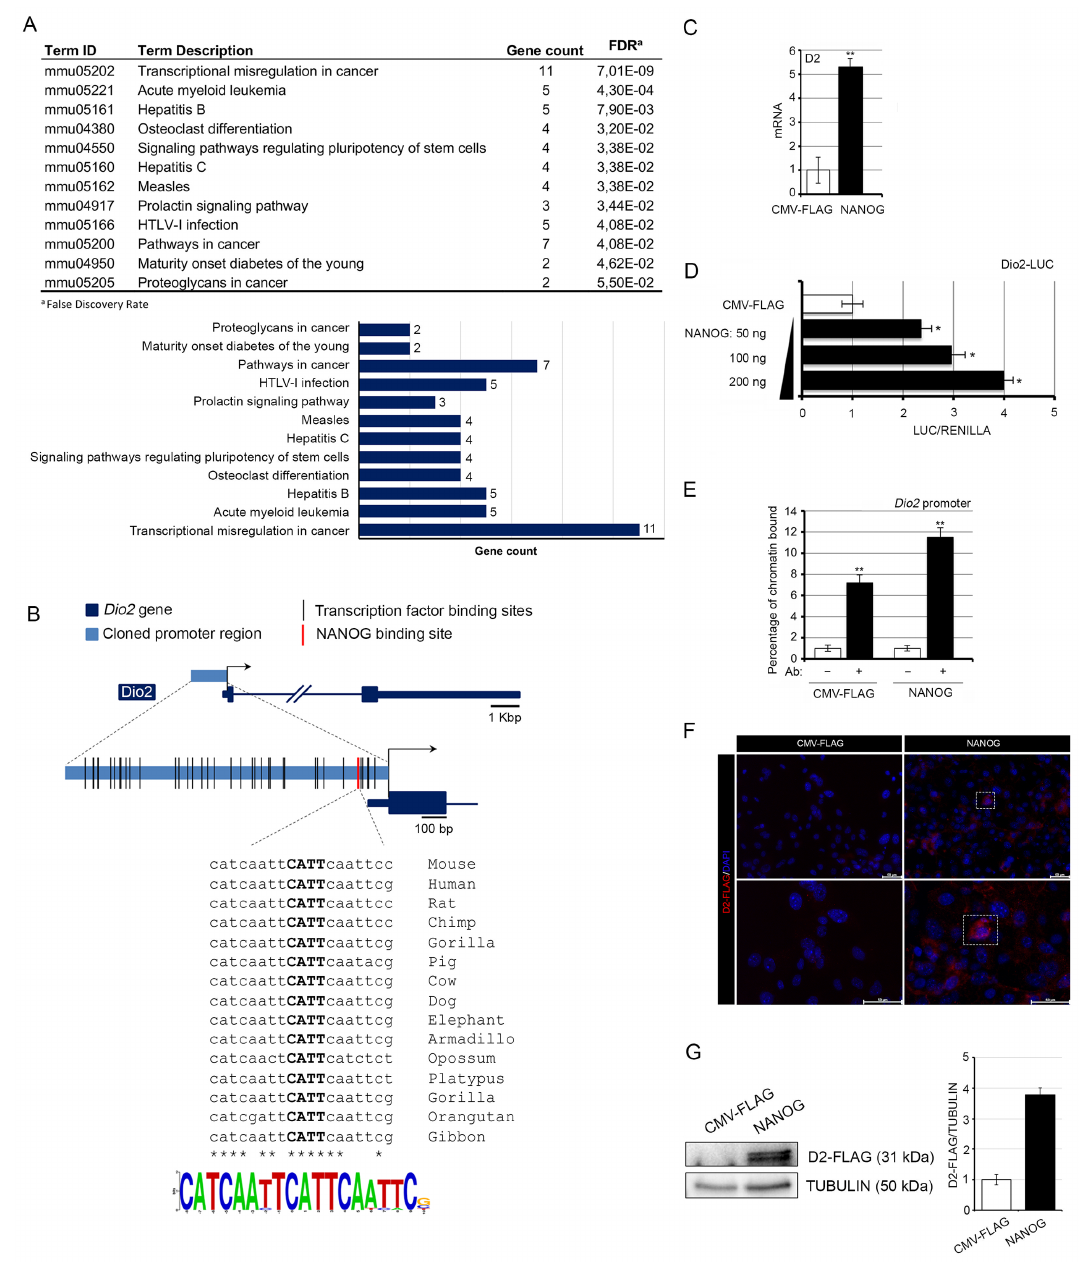
Figure 1. NANOG positively regulates type 2 deiodinase (D2) transcription. ( A ) KEGG pathway clusters generated by the in silico analysis of the Dio2 promoter region. ( B ) Schematic localization of transcription factors and of the NANOG binding site within the Dio2 promoter region; conservation and Logo representation of the NANOG binding motif. ( C ) D2 mRNA expression was measured by real-time PCR in basal cell carcinoma (BCC) cells transiently transfected with a NANOG-expressing vector or the CMV-FLAG plasmid (control). ( D ) BCC cells were transiently transfected with the Dio2–LUC promoter and with increasing amounts of the NANOG plasmid. Cells were harvested 48 h after transfection and analyzed for luciferase activity. CMV-Renilla was co-transfected as an internal control. The results are shown as means ± SD of the LUC / Renilla ratio from at least three separate experiments, performed in triplicate; * p < 0.05, ** p < 0.01. ( E ) Chromatin immunoprecipitation assay was performed in BCC cells. Immunoprecipitation of chromatin using the anti-NANOG antibody revealed that the Dio2 gene is a direct target of NANOG. ( F ) D2-FLAG expression levels were measured by immunofluorescence analysis of mouse primary keratinocytes from D2-Flag mice transfected with the NANOG plasmid or the CMV-FLAG plasmid. Magnification 10 × and 20 × ; scale bars represents 50 µ m. ( G ) Western Blot analysis of D2 expression in the same cells as in